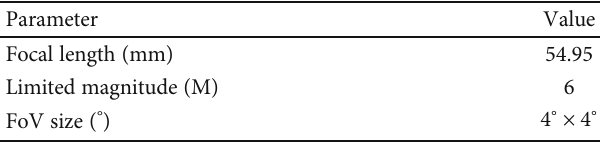
Figure 7: Dynamic establishment of the local star catalog. Table 1: Parameters of the star